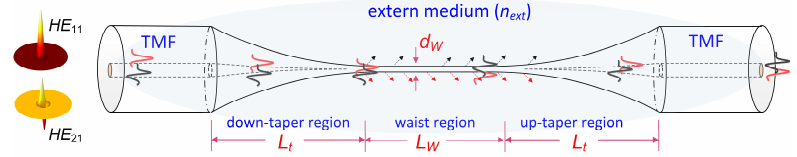
Figure 1. Schematic diagram of the sensor. Quasi-adiabatic transition tapers provide continuous mode evolution from HE 11 and HE 21 modes when the two modes launched into the fiber are collected at the fiber output, respectively.